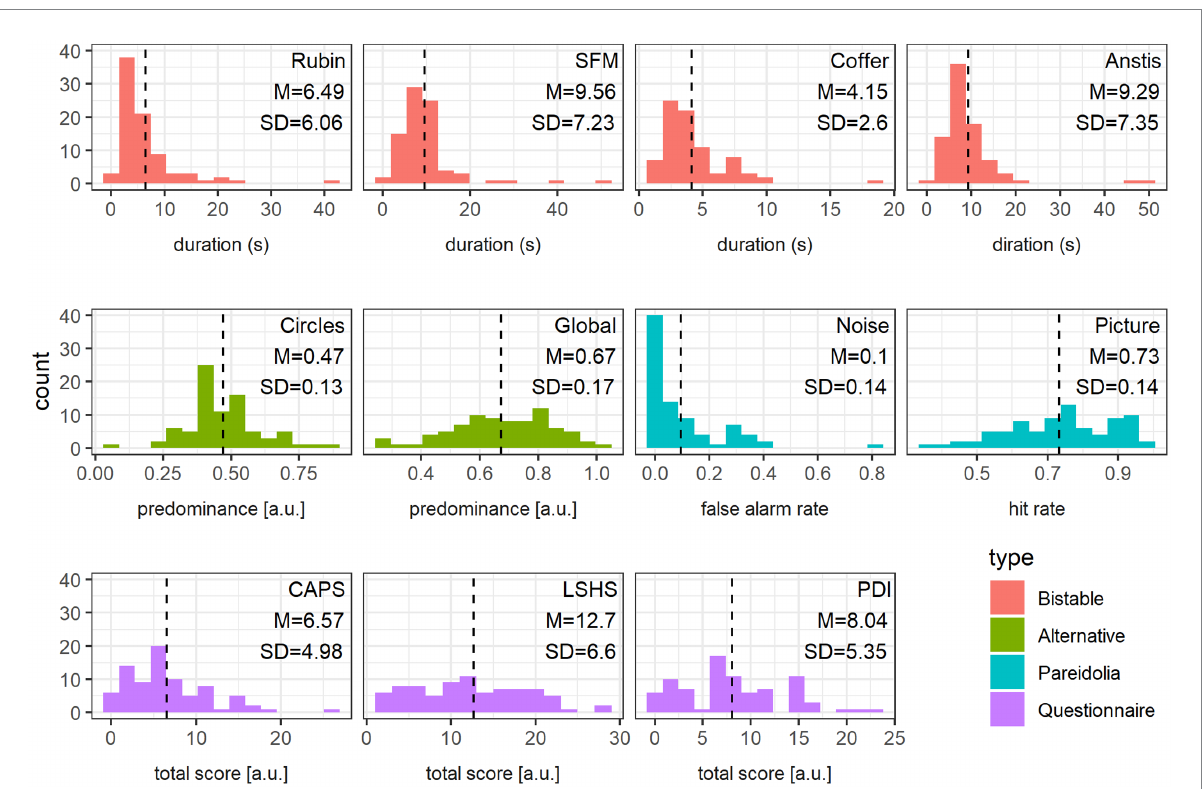
FIGURE 4 Data distribution. Frequency histogram of each variable together with mean (also indicated as a vertical dashed line) and standard deviation values, color-coded according to the variable type: bistable stimuli (red), alternative percept predominance (green), Pareidolia tasks (blue) and Questionnaires